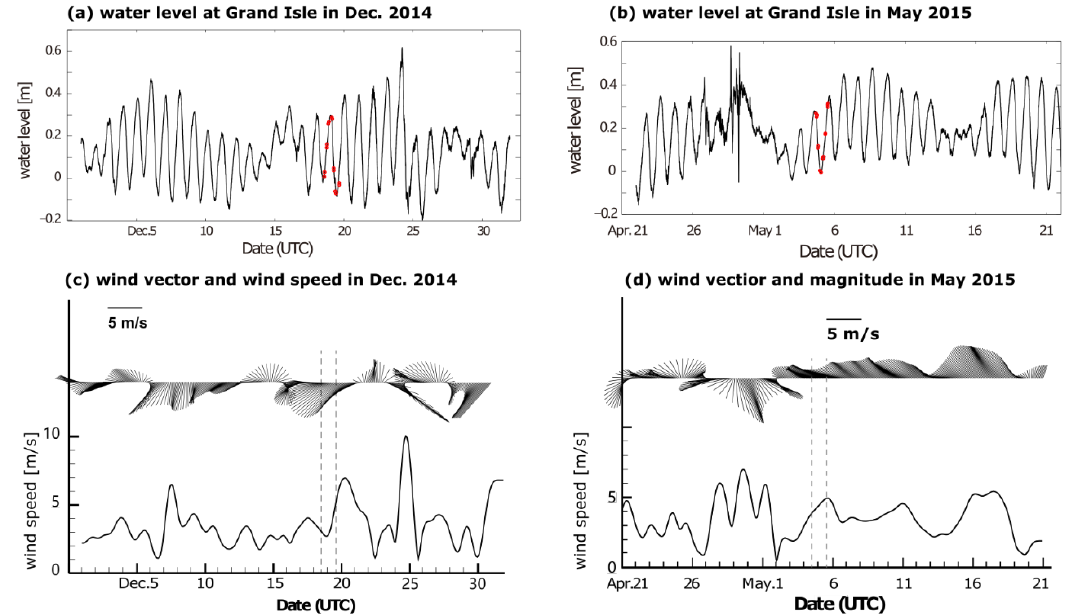
Figure 4. Water levels ( a , b ) and wind vectors ( c , d ) prior, during, and after ADCP investigations. The veering bars in lower panels indicate 40 h lower passed wind vectors with 2 h interval and the curves below show the wind magnitudes. The time of each track is labeled by red dots in both water level records, while the time durations are bounded by vertical dashed lines in corresponding wind fields.